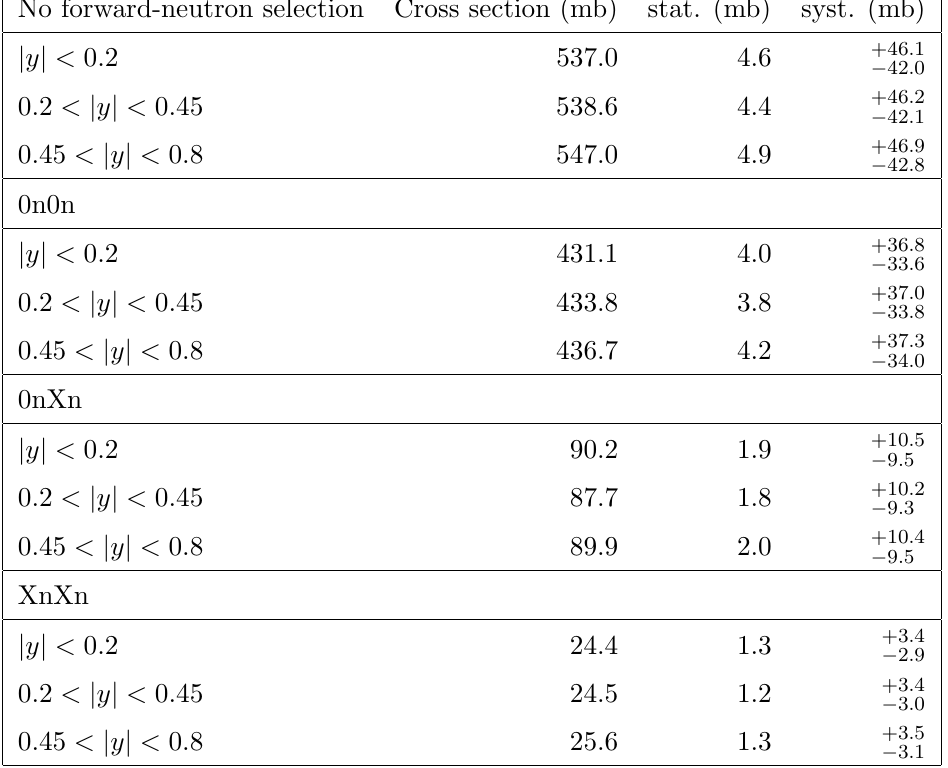
Table 4 . Numerical values of the cross section for the coherent photoproduction of (cid:26) 0 vector p mesons in Pb-Pb UPC at s NN = 5 : 02 TeV. The systematic uncertainties are obtained by adding in quadrature the contributions listed in tables 1 to